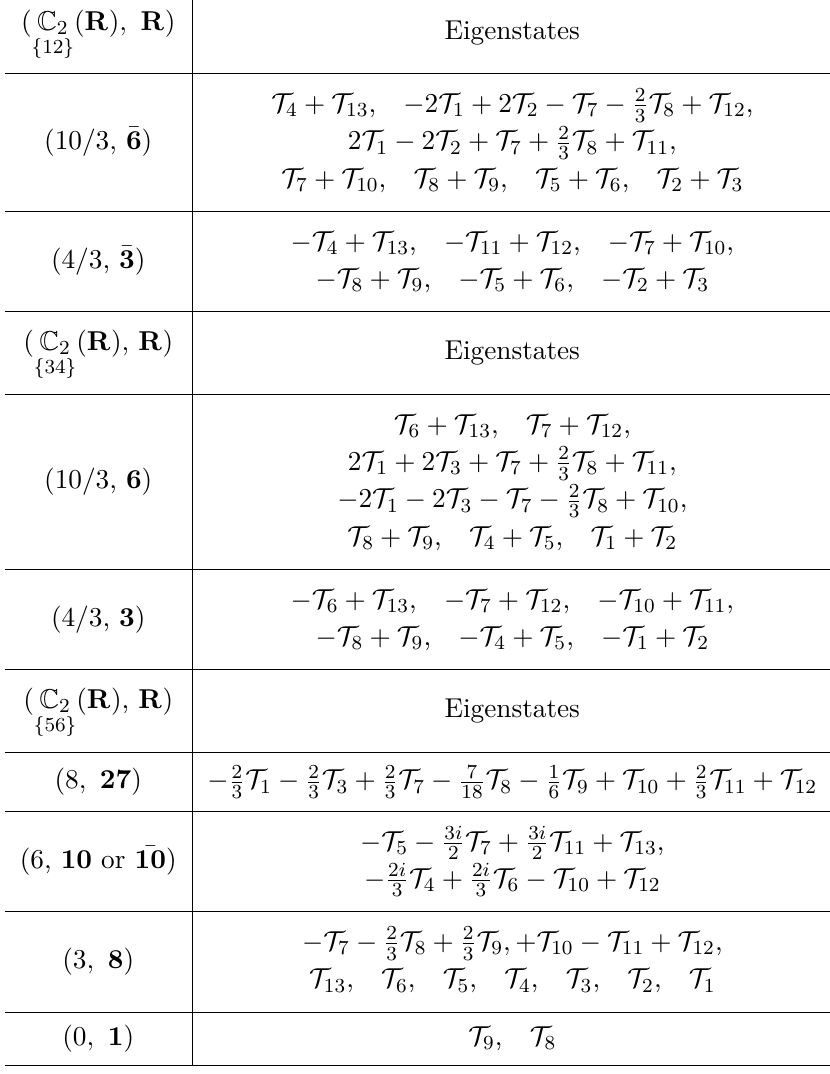
Table 9 . Representations of SU(3) particles { 3 , 3 , ¯3 , ¯3 , 8 , 8 } at channel { 12 } , { 34 } and { 56 } respec-